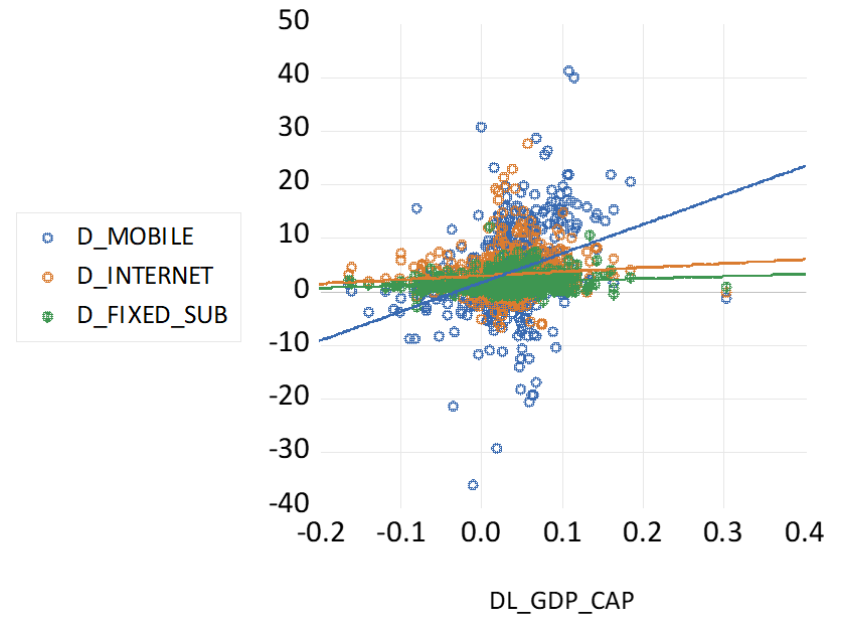
Figure 5 Figure 5. The relationship between digitalisation variables and economic growth. Notes: D_MOBILE, D_INTERNET, and D_FIXED_SUB refer to our interest variables, which are stationary in first